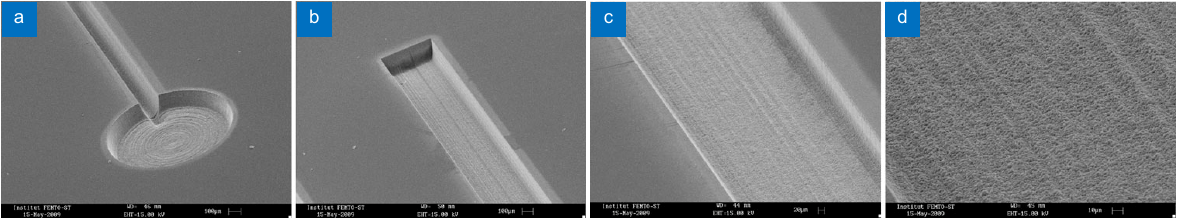
Fig. 12 | SEM images of details microchannels with reservoir ablated in borosilicate glass. ( a ) Channel with reservoir. ( b ) Channel. ( c ) Close-up of the channel. ( d ) Close-up of the bottom of the channel (Ra 100–150 nm). Figure reprinted with permission from ref. 75 , Springer-Verlag. a b